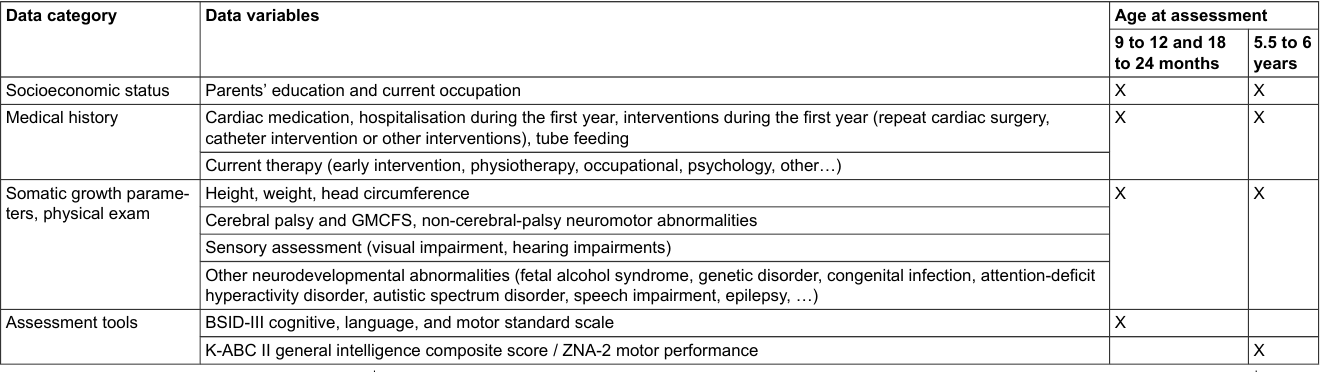
BSID-III: Bayley Scales for Infant Development, 3 rd Edition; GMCFS: Gross Motor Function Classification System; KABC-II: Kaufman Assessment Battery for Children, 2 nd Edition; ZNA-2: Zurich Neuromotor Assessment, 2 nd